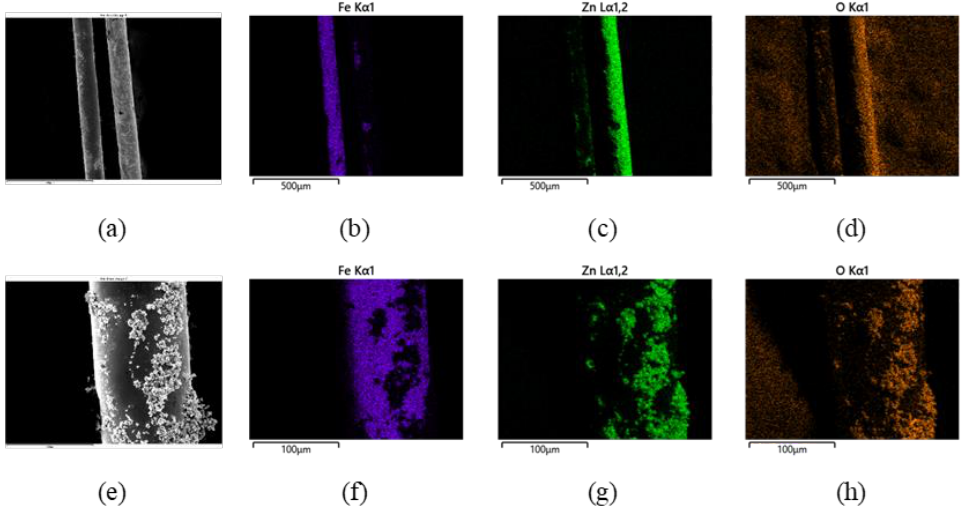
Figure 7. SEM-EDX analysis of the amorphous fibres coated via the hydrothermal technique using a precursor solution of 0.5M concentration and a deposition duration of 6 h. ( a , e )—SEM images, ( b , f )—distribution maps of the Fe, ( c , g )—distribution maps of the Zn, ( d , h )—distribution maps of the O.